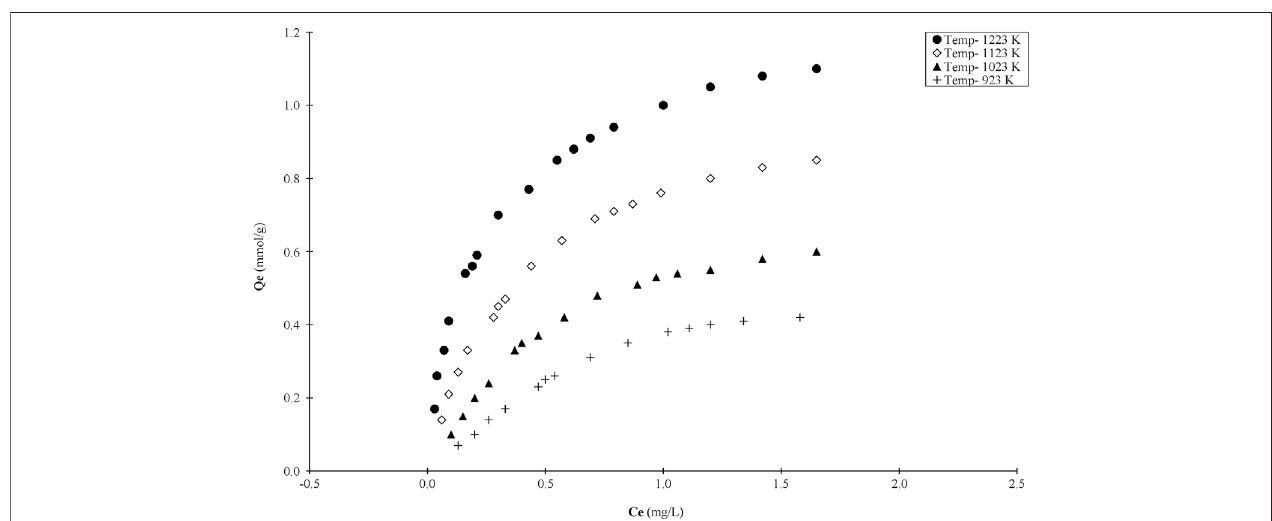
FIGURE 6 | Adsorption curves for MB onto bamboo chars produced at four temperatures (N 2 ; 2 h, 355 – 500 μ m).